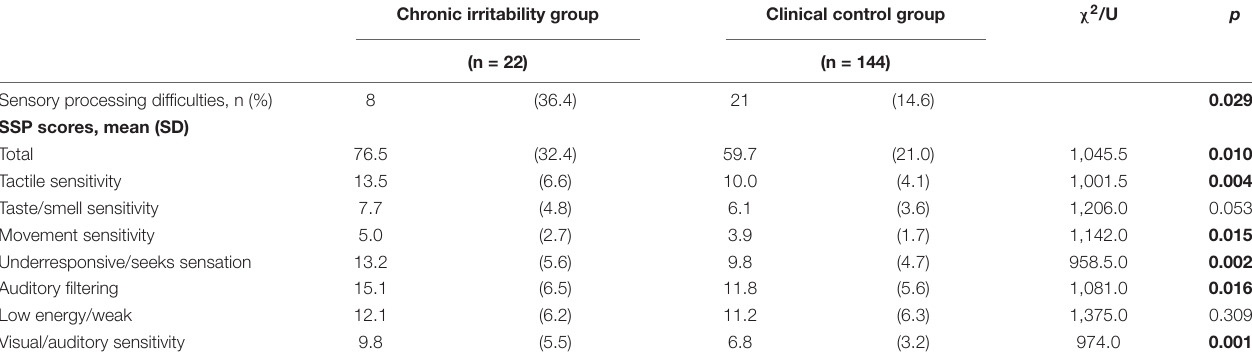
TABLE 3 | Comparison of the prevalence of SPD and Short Sensory Profile scores between the chronic irritability and clinical control groups.